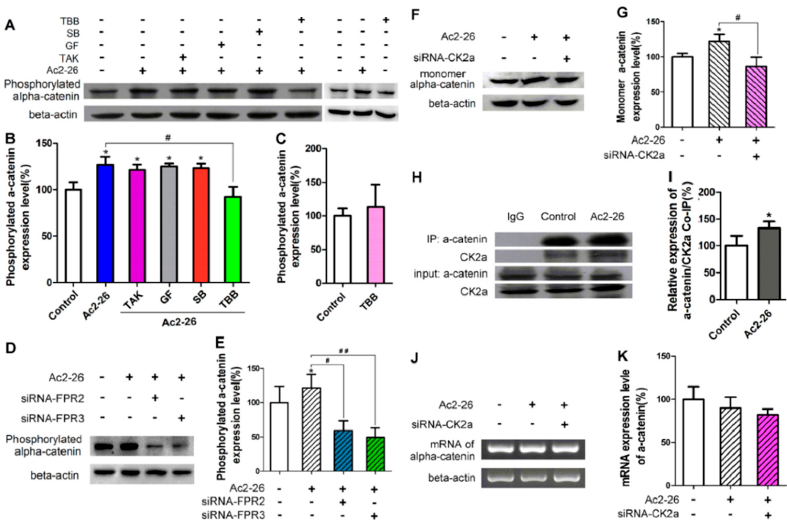
Figure 10. CK2 is involved in Ac2-26-mediated α -catenin phosphorylation in BV-2 cells. ( A ) Western blots illustrating the effects of Ac2-26 and/or the specified inhibitors on phosphorylated α -catenin expression; ( B , C ) results of Western blots illustrate the relative expression level of phosphorylated α -catenin as a percentage relative to the control group; ( D – G ) results of Western blots illustrate that small interfering RNA (siRNA) inhibition of FPR2, FPR3, and CK2 expression led to down-regulation of Ac2-26-induced (1.32 µ M) α -catenin phosphorylation; ( H , I ) co-immunoprecipitation illustrates that Ac2-26 treatment (2.64 µ M) significantly enhanced the CK2- α -catenin binding; ( J , K ) reverse transcription polymerase chain reaction (RT-PCR) results indicate that Ac2-26 treatment or siRNA sequence inhibition of CK2 α expression does not affect the expression of total α -catenin. The final concentration of drugs were as follows: Ac2-26, 1.32 µ M; TBB, 40 µ M; GF, 2 µ M; TAK, 1 µ M; SB, 0.1 µ M. All data are expressed as the mean ± standard error of the mean (SEM) ( n = 4–12). * p < 0.05, (compared to the control groups), # p < 0.05, ## p <